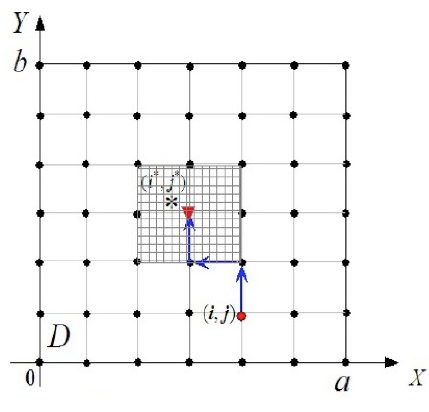
Fig. 2 Random Searching for Radiation Sources